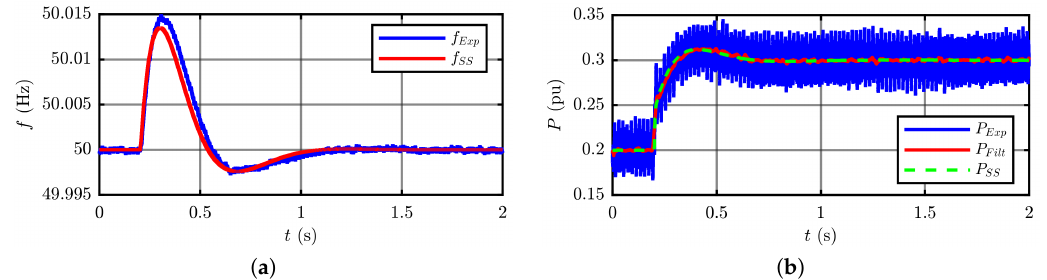
from 0.2 pu to 0.3 pu. From left to right: ( a ) S-VSC Figure 11. Test 1: Step in active power reference ∆ P ∗ ext virtual rotor speed (Hz) from experimental test (Exp) and state-space model (SS); ( b ) Active power injected from the inverter (pu) from experimental test (Exp), filtered active power (Filt) and output of the state-space model (SS).